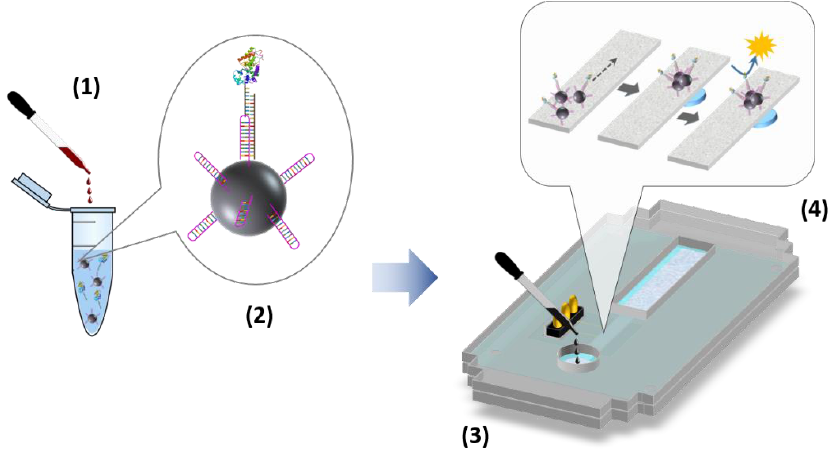
Figure 7. Scheme of the electrochemical biosensor platform and the analytical procedure: 1 — sample addition to a solution containing functionalized MNPs and the detection oligonucleotide labeled with HRP enzyme; 2 — hybridization assay on the MNP surface; 3 — pretreated sample added to the electrochemical device; 4 — steps taken place in the electrochemical device, including MNP flow, trapping and concentration, and electrochemical detection.